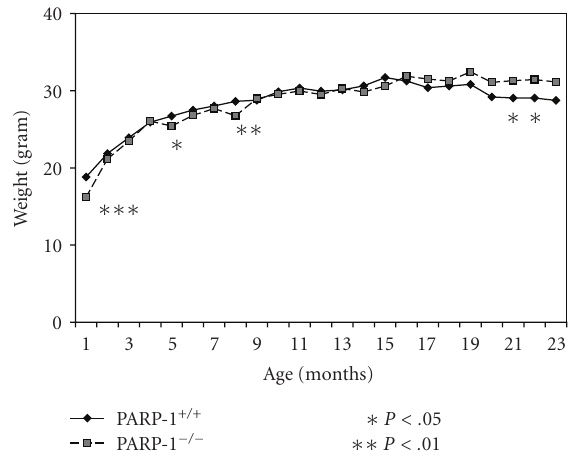
Figure 1: Age-related dynamics of body weight in PARP-1 − / − and PARP-1 + / + mice. PARP-1 − / − and PARP-1 + / + mice were measured every month for their body weight throughout a period of 23 months. Student’s t test was performed to analyze the statistical significance of the results.